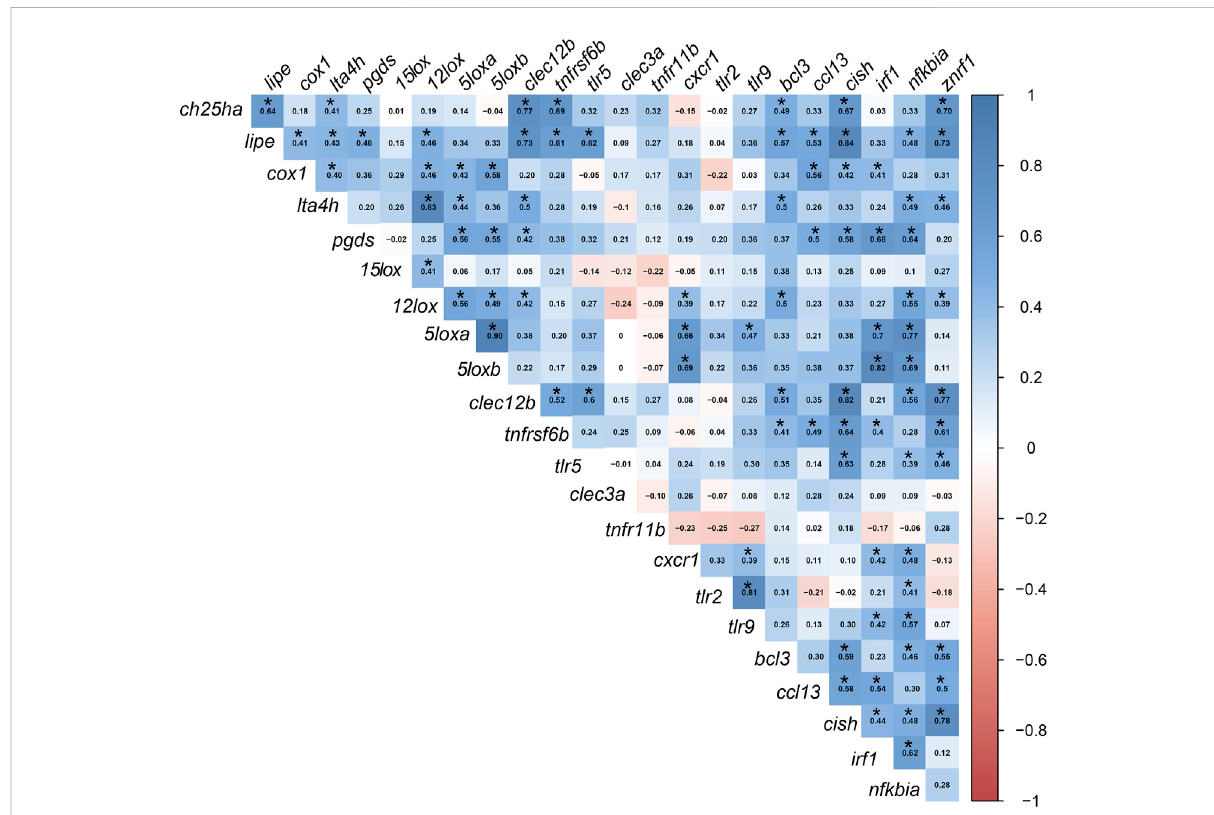
FIGURE 5 Pearson ’ scorrelationcoef fi cient(r)matrix forthefold-changeofthetargeted transcripts. FCswerecalculatedusing individual RQ(n =9)ofthe bacterin-stimulated individual/average RQs of the PBS-injected fi sh for each group. Created using the “ corrplot ” R-software package. Signi fi cant correlations with p ≤ 0.05 are indicated by an asterisk (*) on the r values in the cells (blue for positive correlations and red for negative